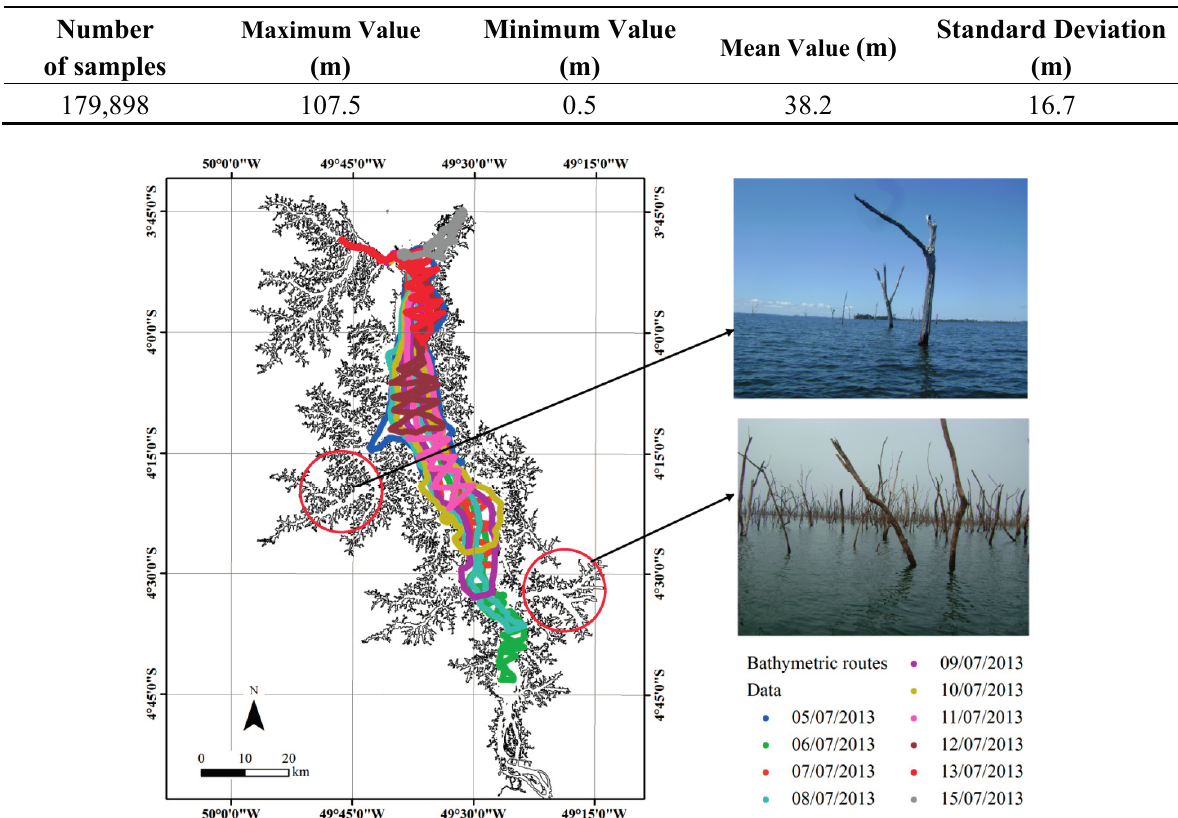
Table 1. Statistical summary of the depth sample dataset.